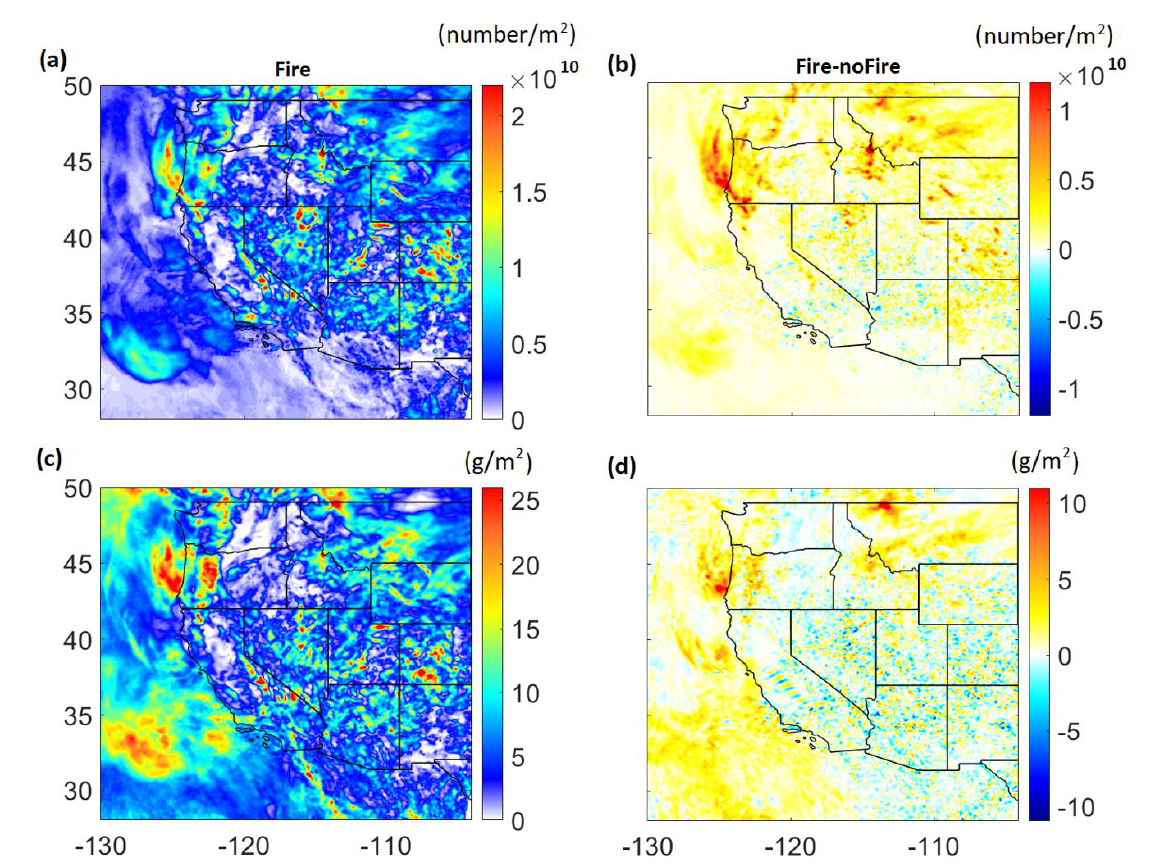
Figure 12. Spatial distribution of average ( a ) vertically integrated droplet number concentration in number/m 2 from ‘Fire’ simulation, ( b ) difference in vertically integrated droplet number concentration in number/m 2 between the ‘Fire’ and ‘noFire’ simulations, ( c ) vertically integrated cloud water concentration in g/m 2 from the ‘Fire’ simulation and ( d ) difference in vertically integrated cloud water concentration in g/m 2 between the ‘Fire’ and ‘noFire’ simulations for the first half of September 2017.